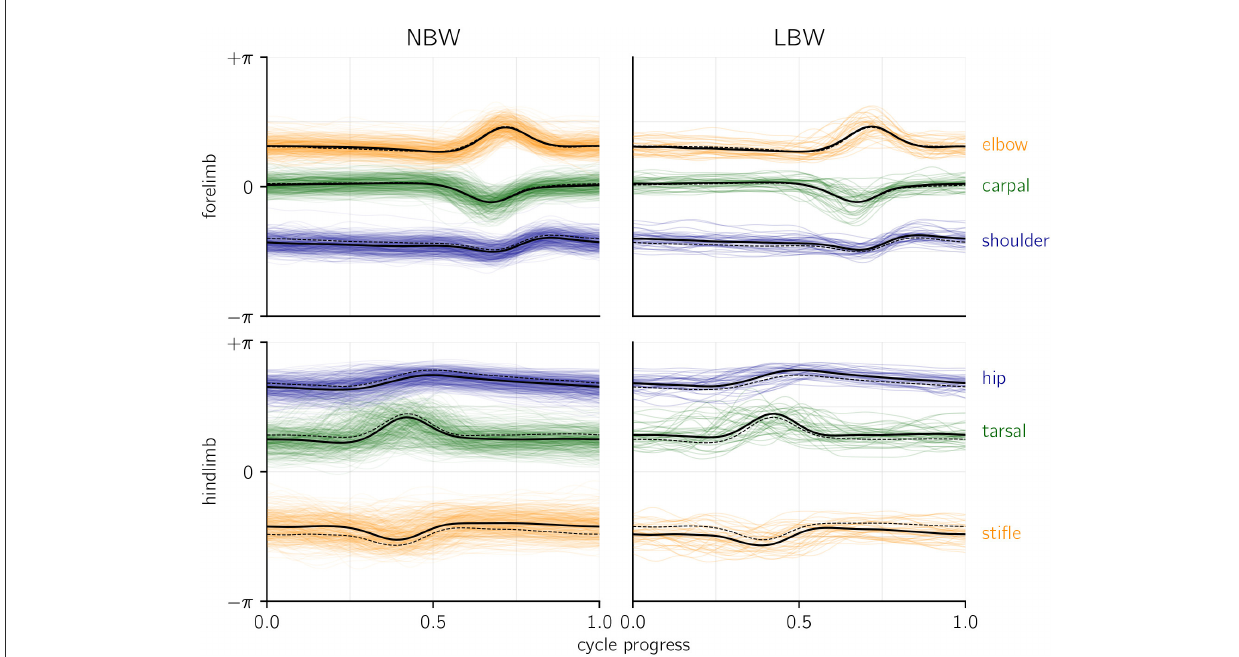
FIGURE3 Joint angle profiles per joint, grouped by birth weight category. An angle of zero would be a fully extended (i.e., straight) joint. Thick lines represent the average profiles, dashed lines indicate the average of the opposite birth weight group for comparison. Colored, shaded lines show all raw profiles available for the present analysis. Temporal alignment was done based on total forelimb angle (see methods), yet for the shown hindlimb averages (but not for the raw profiles), a separate alignment of the hindlimb was performed.